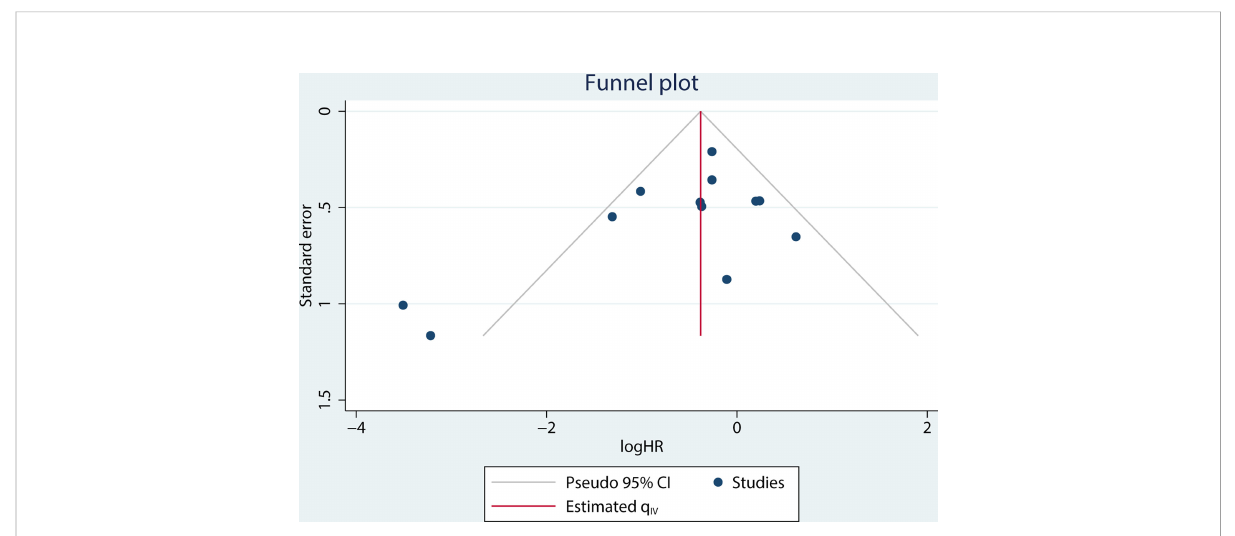
FIGURE 9 Funnel plot for studies on the association between MCPyV positivity and overall survival